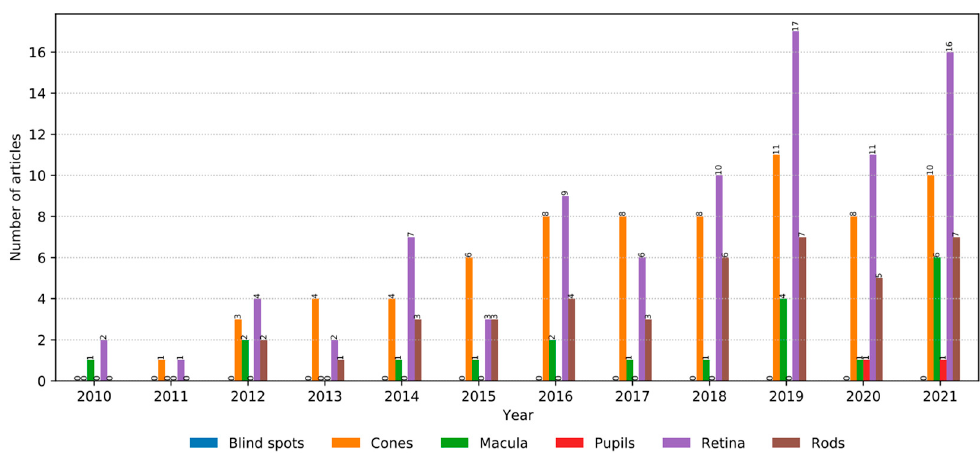
Figure 4. Distribution of AI/ML Problem types.